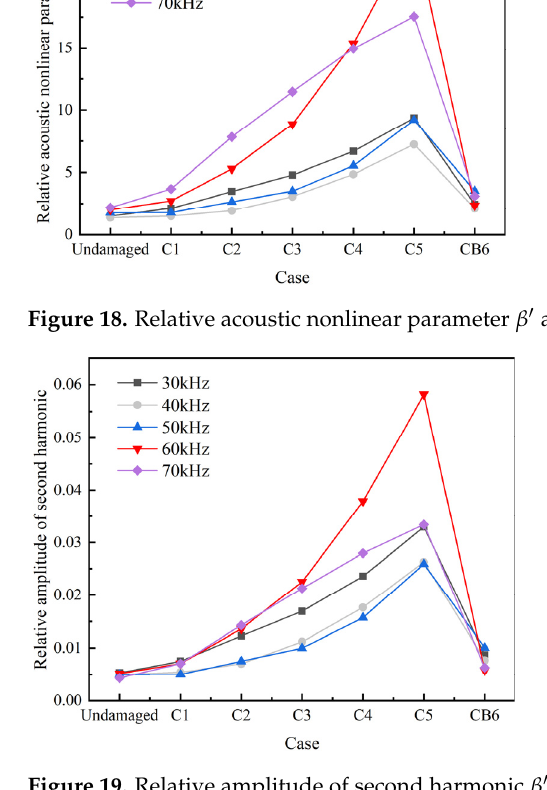
Figure 19. Relative amplitude of second harmonic β (cid:48) re at different cases